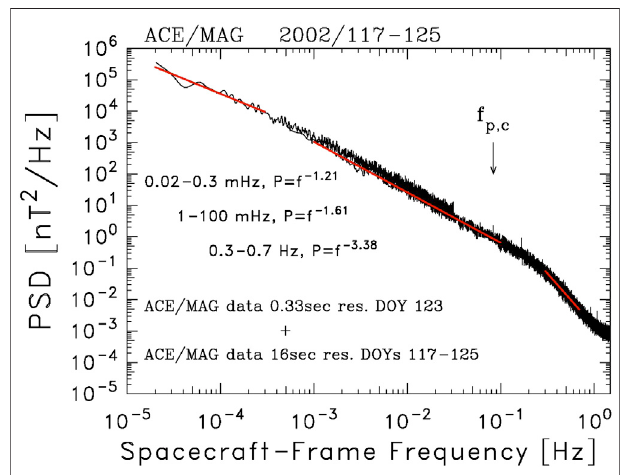
FIGURE 2 | Composite spectrum using a nine-day interval of low- resolution magnetic fi eld data from the ACE spacecraft and a single day of high-resolutiondata.Frequencies > 1 Hzshowaliasingfromunresolvedhigher frequencies. The analysis is described in the